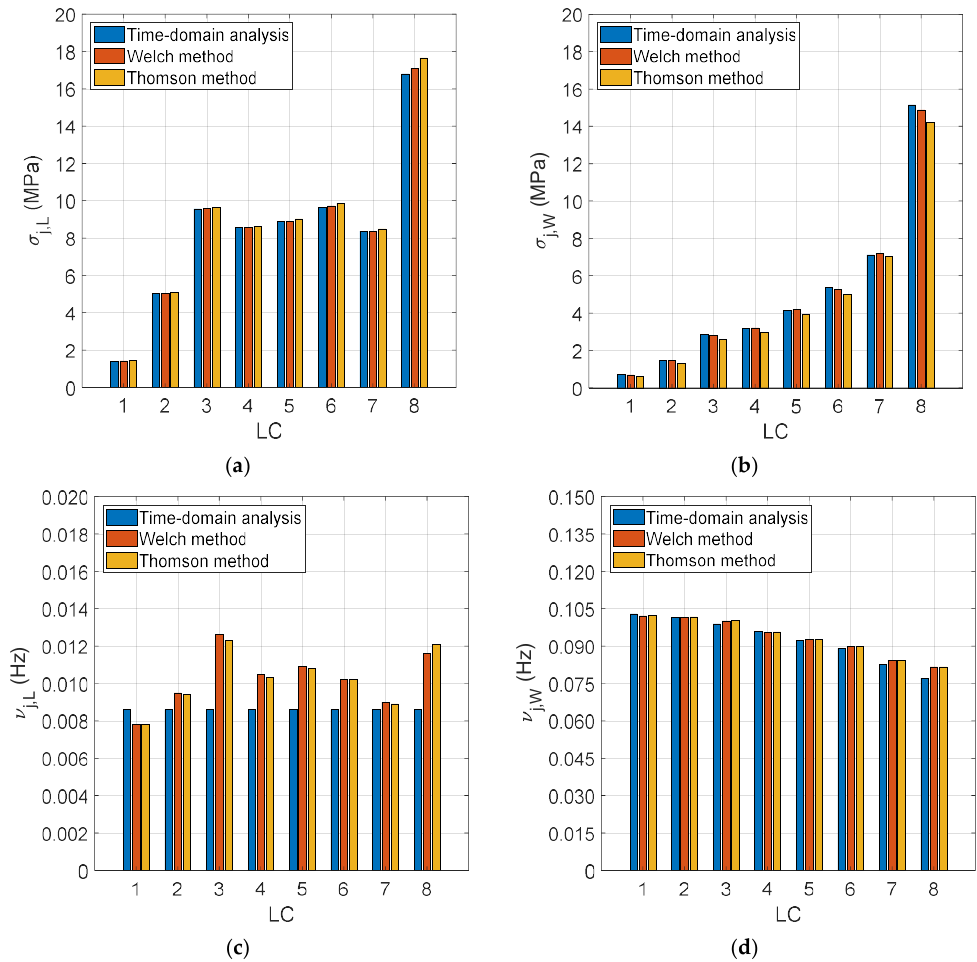
Figure 8. Comparative analysis between time- and frequency-domain models. ( a ) Standard deviation of the low-frequency stress component; ( b ) standard deviation of the wave-frequency stress component; ( c ) up-crossing rate of the low-frequency stress component; ( d ) up-crossing rate of the wave-frequency stress component.